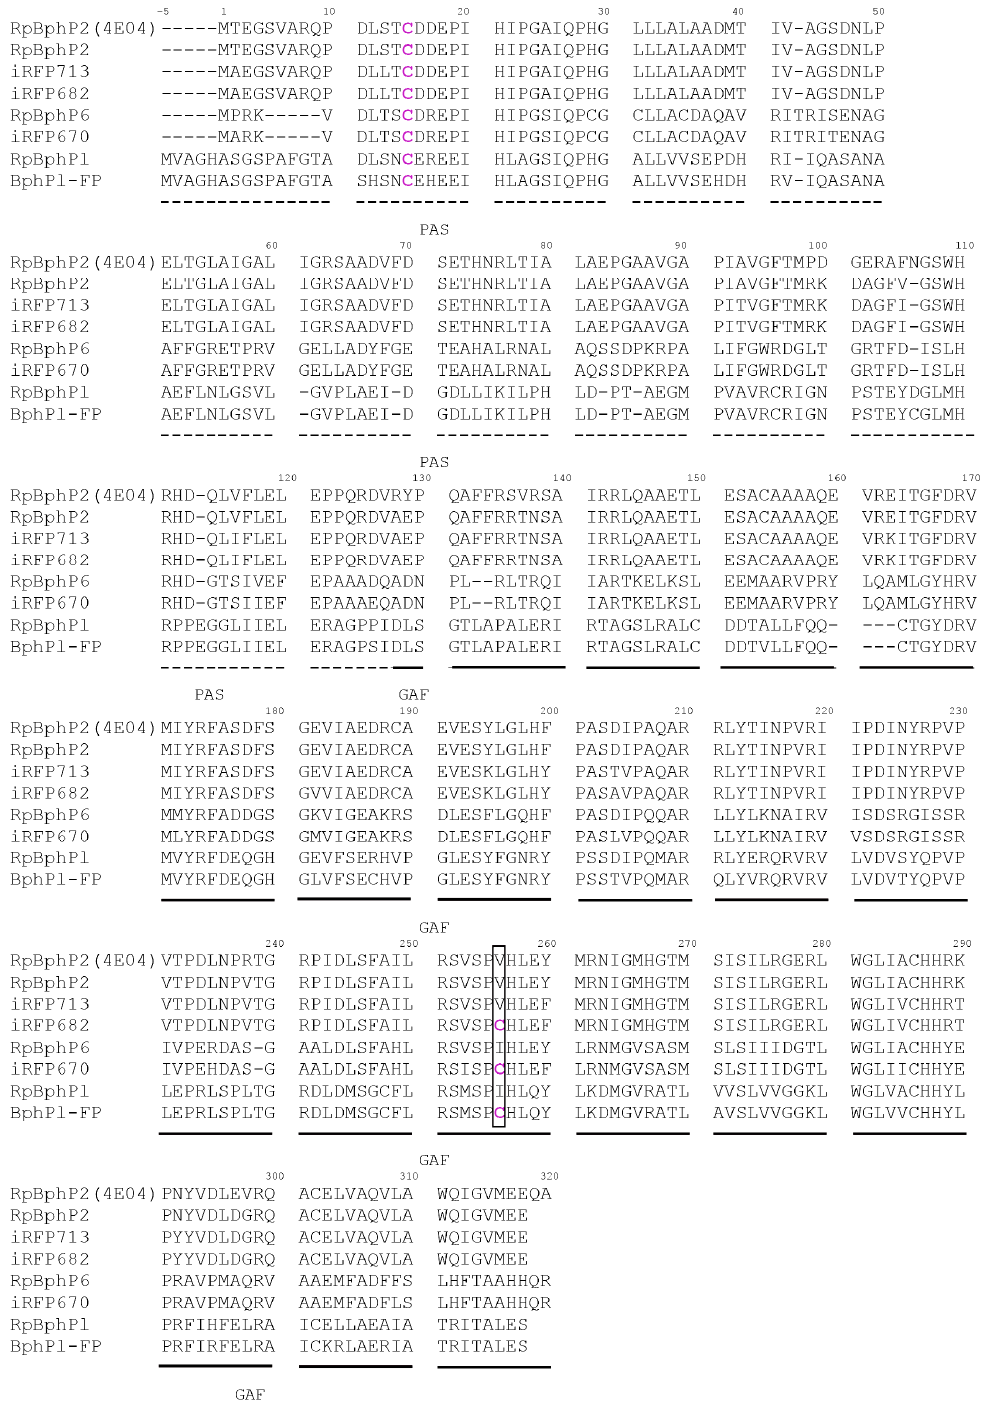
Figure 1. Alignment of amino acid sequences of the fluorescent protein BphP1-FP derived from bacterial phytochrome RpBphP1, near-infrared fluorescent protein iRFP670 and iRFP682/iRFP713 proteins with chromophore-binding domain (CBD) of their natural templates RpBphPl, RpBphP6 and RpBphP2 (and its crystallized variant, RpBphP2 (PBD ID: 4E04)), respectively. Conservative Cys residue in the Per-ARNT-Sim repeats (PAS) domain of all BphPs (Cys15) and engineered Cys residue in the cGMP phosphodiesterase/adenylate cyclase/FhlA transcriptional activator (GAF) domain of iRFP670, iRFP682 and BphPl-FP (Cys256) proteins are shown in magenta. PAS and GAF domains are highlighted with dashed and solid lines, respectively. Cys residue introduced into a conservative –SPXH- motif of the GAF domain is shown in the frame.